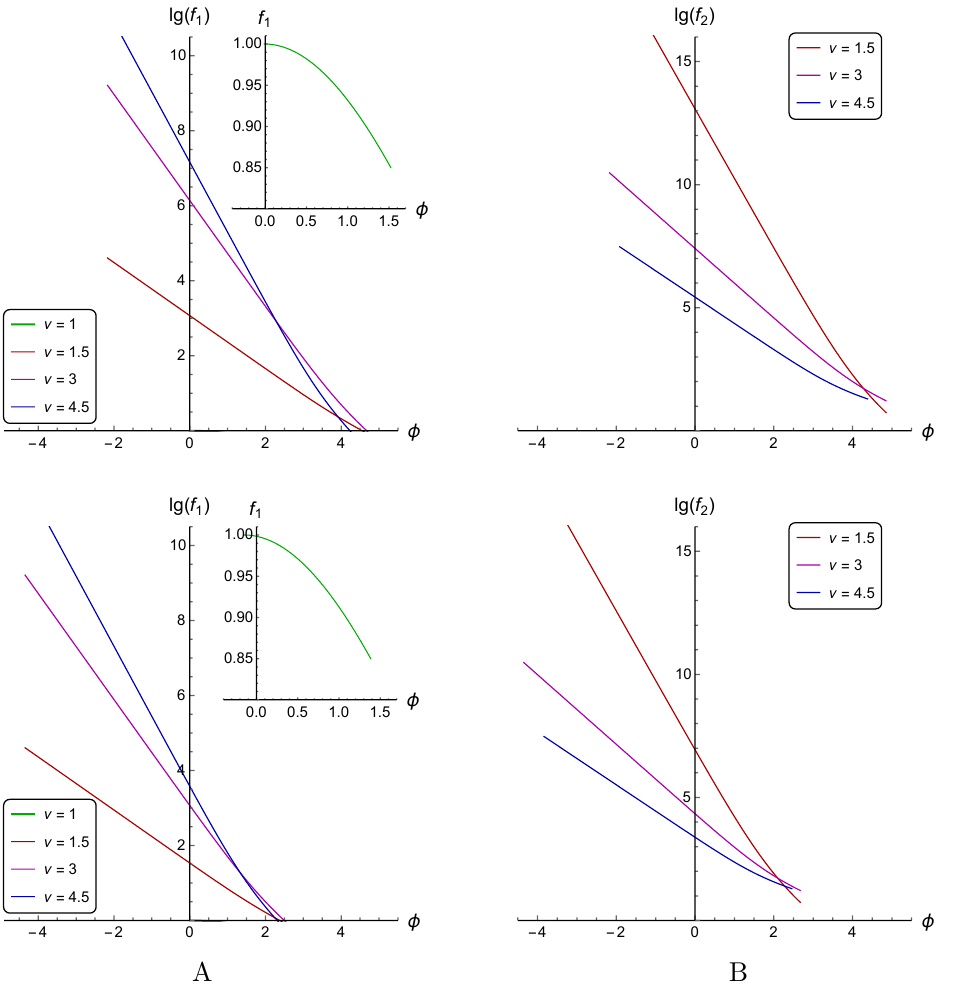
Figure 9 . Coupling functions f 1 ( φ ) (A) and f 2 ( φ ) (B) in logarithmic scale for different anisotropy ν , z 0 = 0 . 01 (1-st line) and z 0 = 0 . 1 (2-nd line), a = 4 . 046 , b = 0 . 01613 , c = 0 . 227 and q = 1